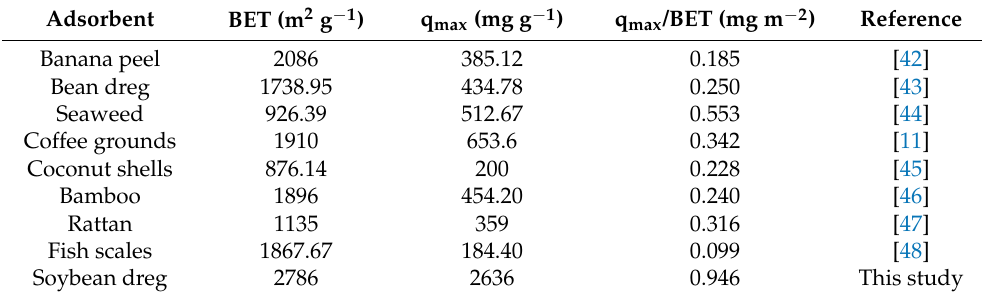
Table 6. Comparation of the maximum MB adsorption capacities of adsorbents prepared from different